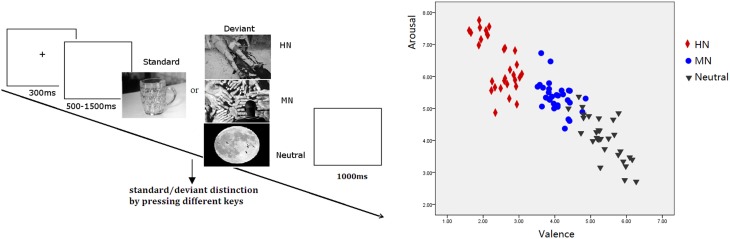
Left: Schematic illustration of the behavioral procedure and the picture examples; Right: The scatterplot for the valence and arousal for HN, MN, and Neutral pictures.